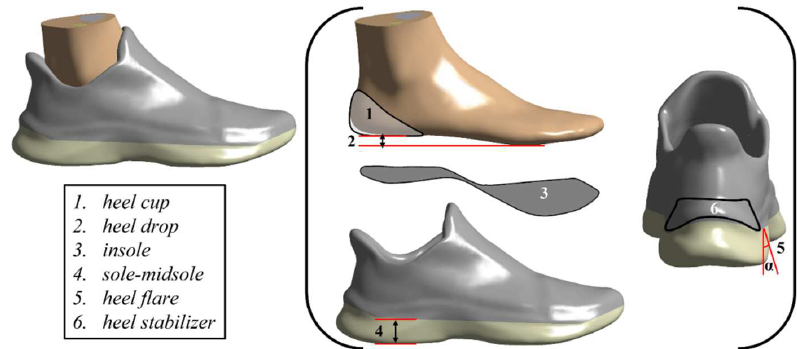
Figure 3. The main design aspects of running shoes.